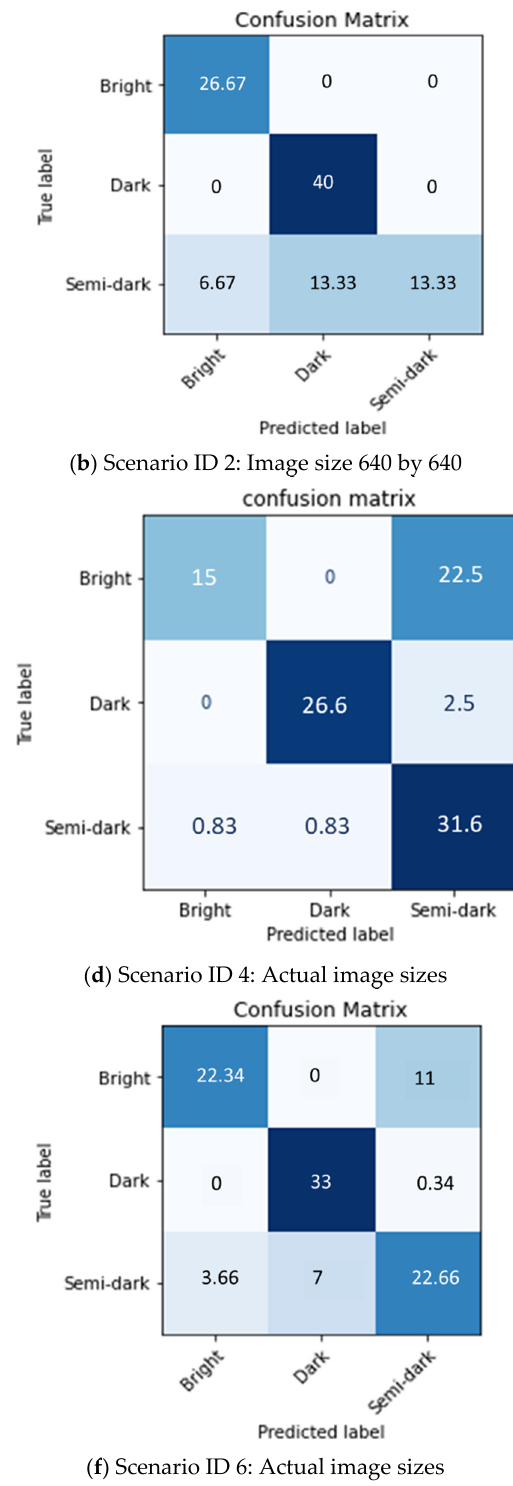
Figure 10. Percentage form confusion matrix of basic CNN ( a , b ), SVM ( c , d ), and RPLC ( e , f ). The numeric forms of the confusion matrices obtained from the experimental validation were converted in percentage forms for the sake of uniformity in argument. In Figure 10a the percentage of correctly classified images is about 66.76%, whereas incorrectly classified images are up to 33.33%. For Figure 10b the percentage of correctly classified images is 80% and incorrectly classified images hold 20%. In Figure 10c the percentage of correctly